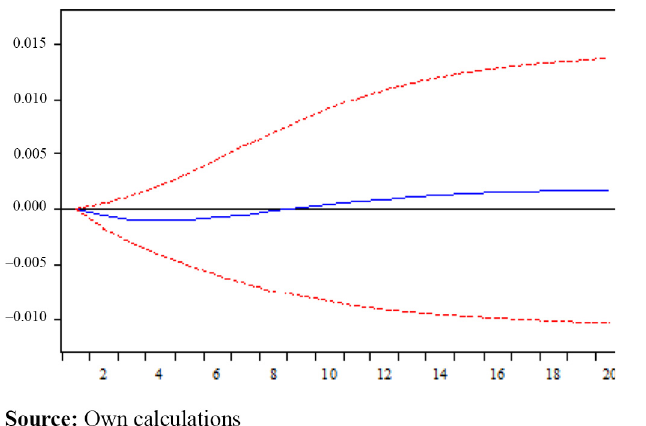
Figure 10. Response of LGDP to